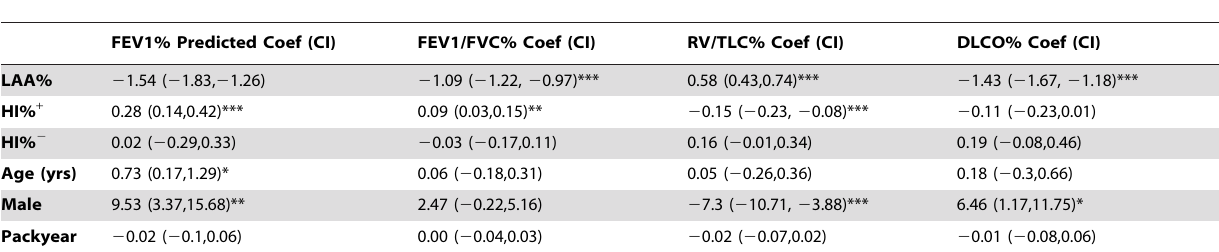
Table 3. Multiple linear regression results for different pulmonary function measures among subjects with COPD (n =160).